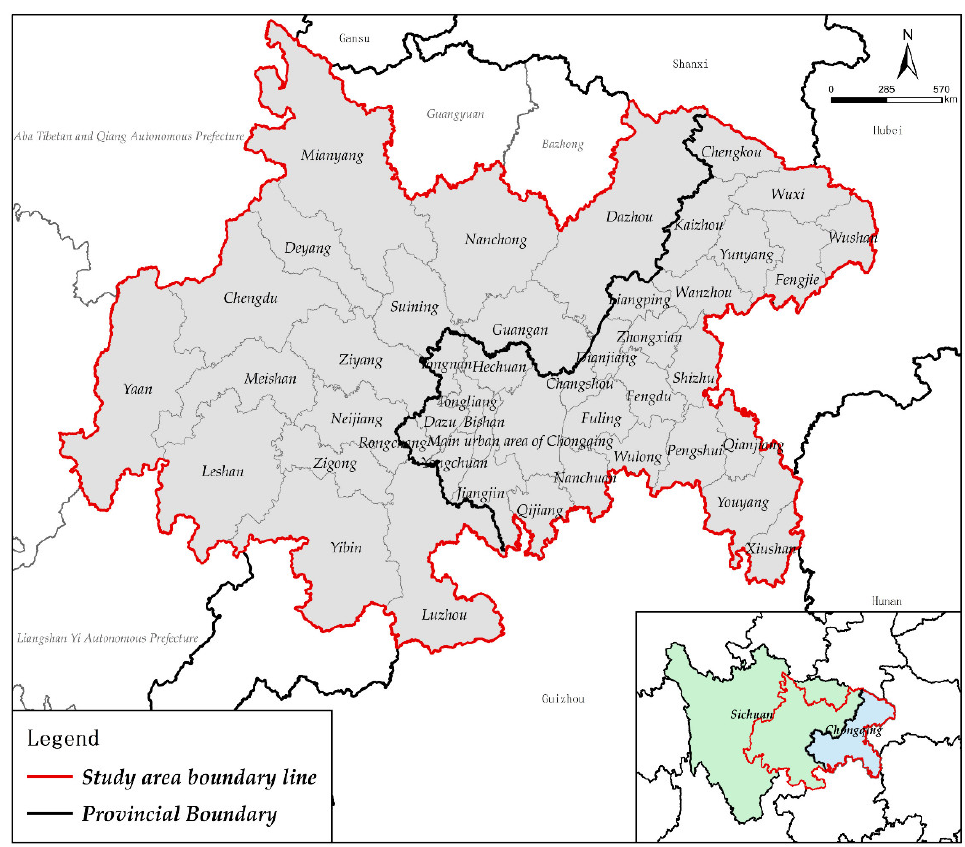
Figure 1. Location of study area.